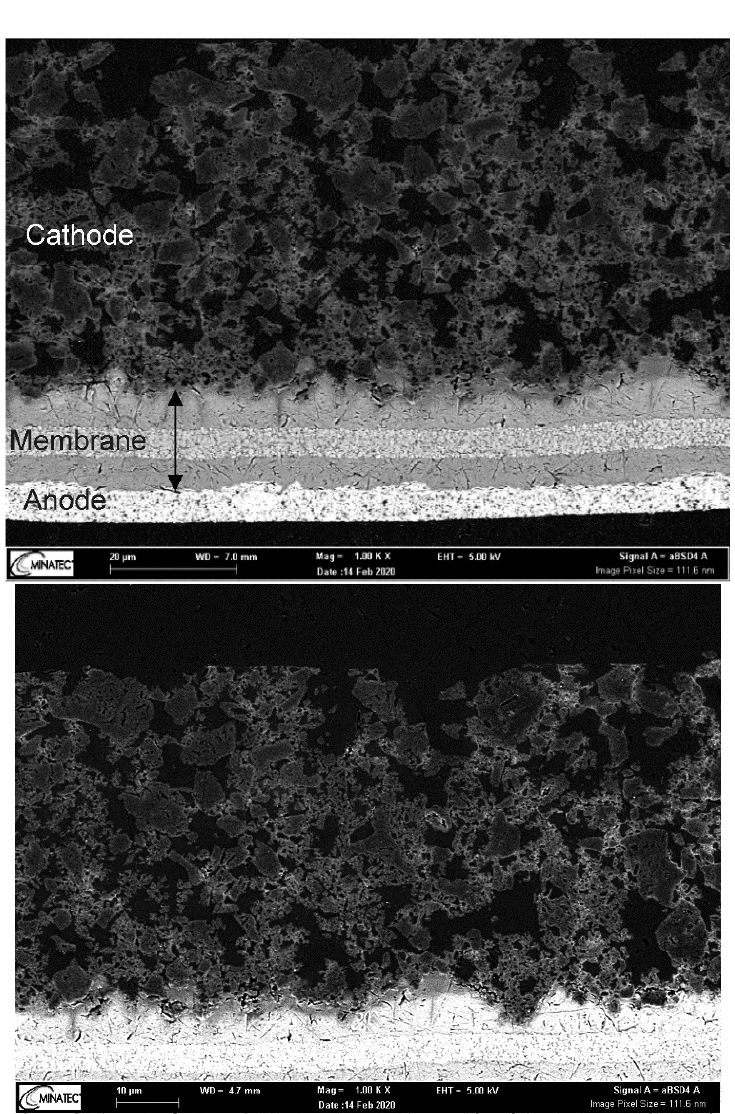
Figure 4. SEM images (high brightness mode) of cross sections of CCM made using bar coating; the scale bar is 20 μ m ( up ) and 10 μ m ( down ).